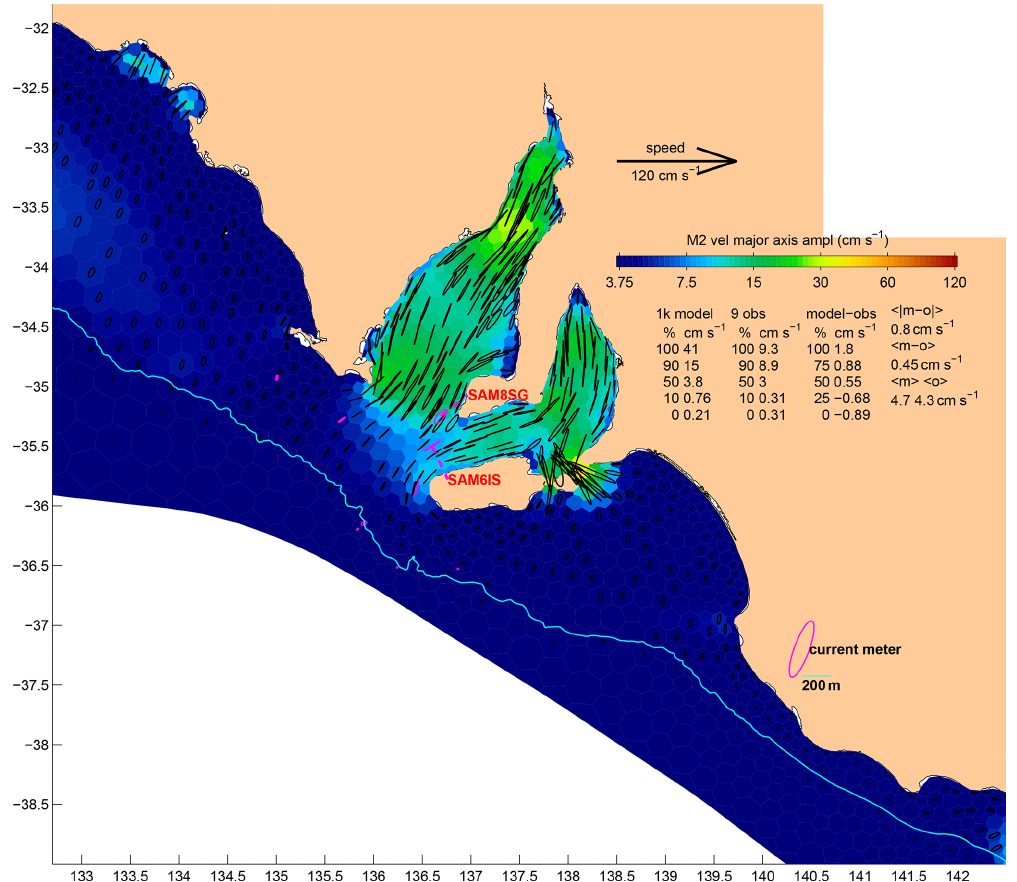
Figure 13. Amplitude of the M2 major axis velocity for the South Australia region; otherwise like Fig.